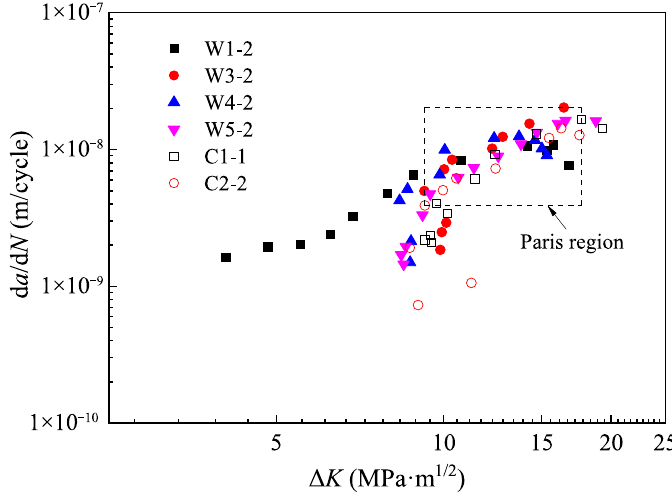
Figure 19. Fatigue crack propagation rates.